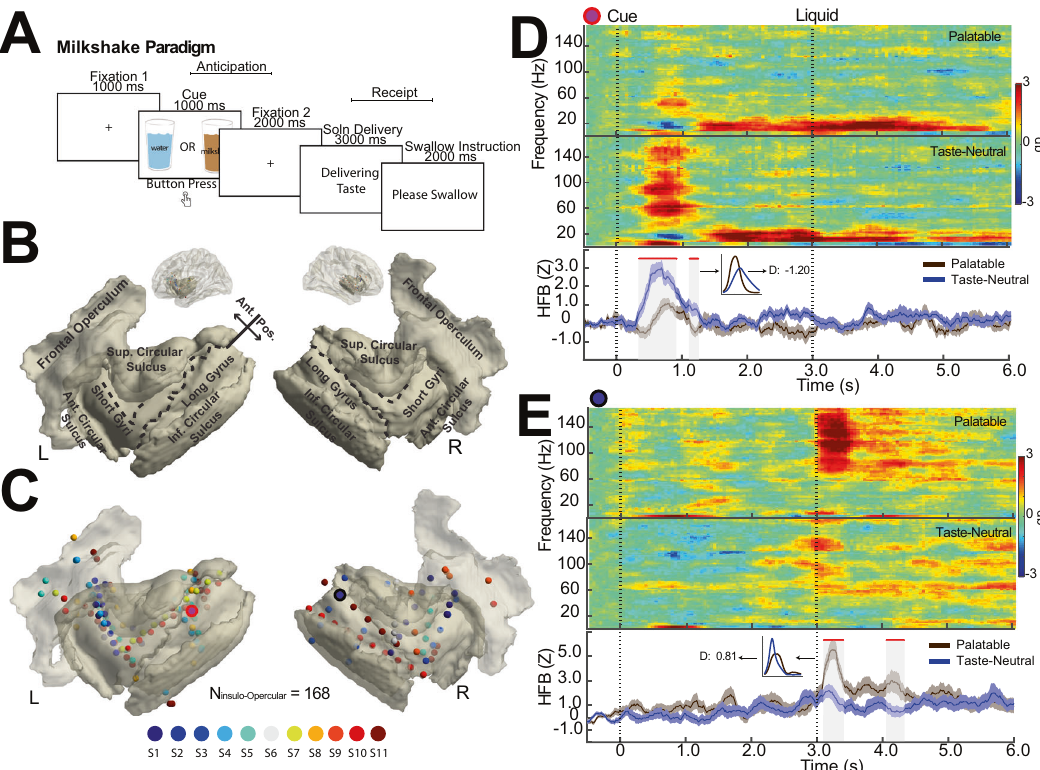
Fig. 1 The milkshake paradigm evokes responses in the human frontal opercular and insular cortices. A The task paradigm. All subjects performed a food task that involved responding to cues of either palatable (chocolate milkshake) or taste-neutral (water-based solution) liquid and subsequently receiving 3 mL bolus. The anticipatory phase of the task was de fi ned as the onset of the cue immediately prior to solution delivery (0 to 3 s). The receipt phase of the task was de fi ned from solution delivery to immediately prior to swallowing (3 s to 6 s). B Freesurfer parcellation of the insular/opercular cortex. The insula was divided into anterior-posterior subregions based on the central sulcus of the insula. The anterior insula includes the short gyri, the anterior (ant.) circular sulcus, and the superior (sup.) circular sulcus; the posterior insula includes the long gyrus and the inferior (inf.) circular sulcus. The frontal operculum is de fi ned as the inferior frontal gyrus. C Magnetic resonance image reconstruction of the insular cortex and the frontal operculum overlaid with the translucent cortical surface. All insular/opercular recording contacts are plotted as 3D spheres, color-coded according to subjects, in the Montreal Neurological Institute (MNI) space. D Time-frequency spectrogram (decibel, db) and high-frequency broadband (HFB) activity waveform from an insular electrode in a left long gyrus (red circled electrode in C ) showing differential responses to palatable vs. taste-neutral cue during anticipation. Time points signi fi cantly different between palatable and neutral conditions ( p < 0.05, cluster-based permutation testing, α < 0.05) are marked in red along the horizontal axis. The effect size was calculated using time periods that were considered signi fi cant as marked by red. The vertical dashed line denotes the onset of the solution cue ( t = 0 s) and solution delivery ( t = 3 s). Inset: distribution of mean HFB activity strati fi ed by palatable and neutral trials with the effect size indicated. E Identical data representation as shown in D for an electrode in the right superior circular sulcus of the insula (black circled electrode in C ) showing differential responses to palatable vs. taste-neutral solution during receipt. Error bars show